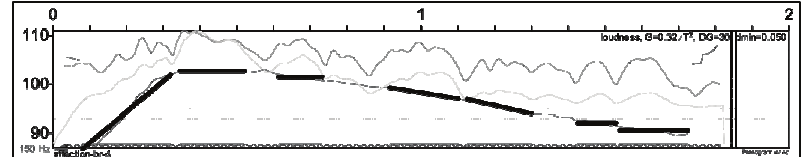
Figure 1: Illustration of the Prosogram of an affection instance (“hmmmm nham nham nham nham nham nham”). The horizontal axis represents time in seconds and the vertical axis shows semitones (relative to 1 Hz). Intensity is represented in the green line, fundamental frequency in the blue line, and the intensity of band-pass filtered speech in the cyan